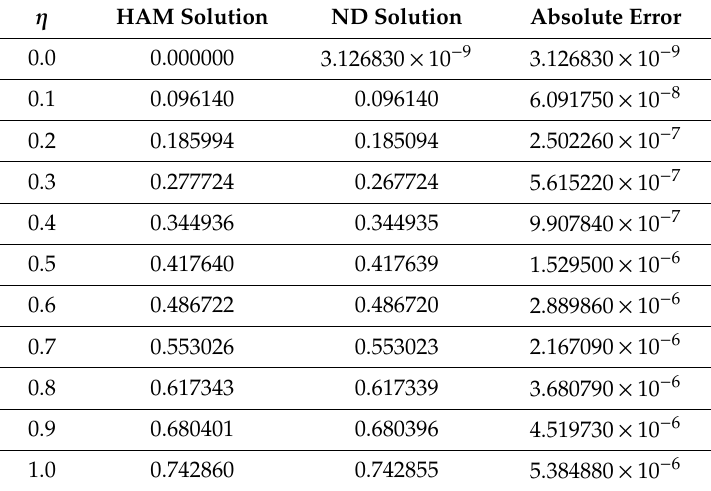
Table 2. Comparison of HAM and ND-Solve for velocity function f (cid:48) ( η ) w.r.t. di ff erent values of the dimensionless variable η .